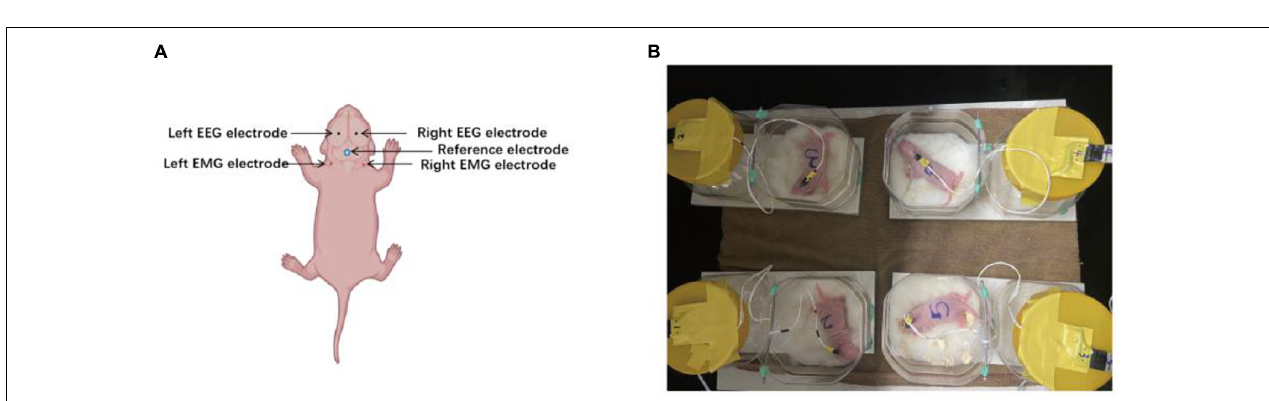
FIGURE 1 | Schematic representation of the experimental design in HI and sham-control group rats. P, postnatal day; hrs, hours; HI, hypoxia–ischemia.